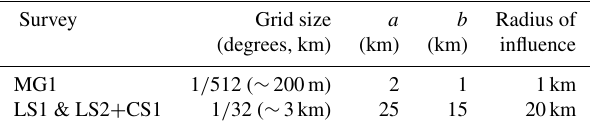
Table A1. Objective analysis mapping